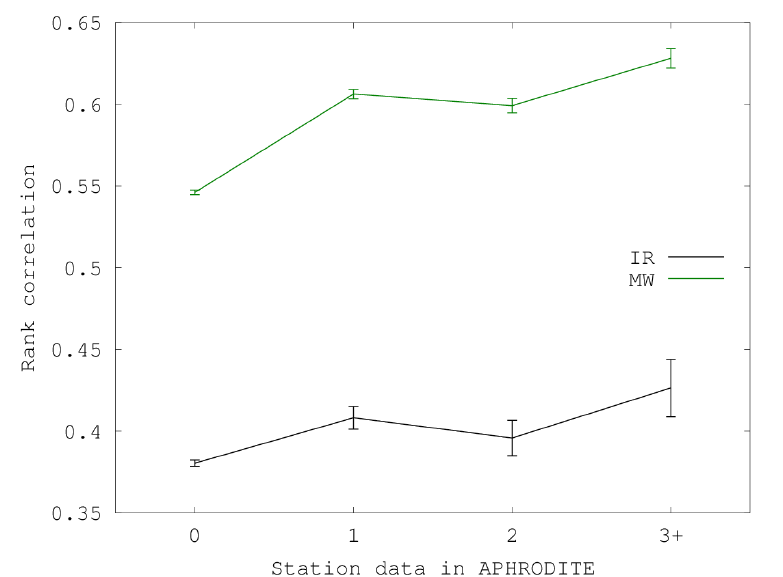
Figure 4. Rank correlation of daily precipitation between the satellite-based 3B42RT product and APHRODITE as a function of both station data coverage (expressed as the number of 0.05 ◦ subcells in a 0.25 ◦ grid cell with precipitation gauges) and satellite data coverage (availability of higher-quality microwave (MW) sounder precipitation estimates for at least 4 of the daily 3-hour windows versus only lower-quality estimates based on infrared (IR) imagery). Error bars are 95% confidence intervals for the correlation